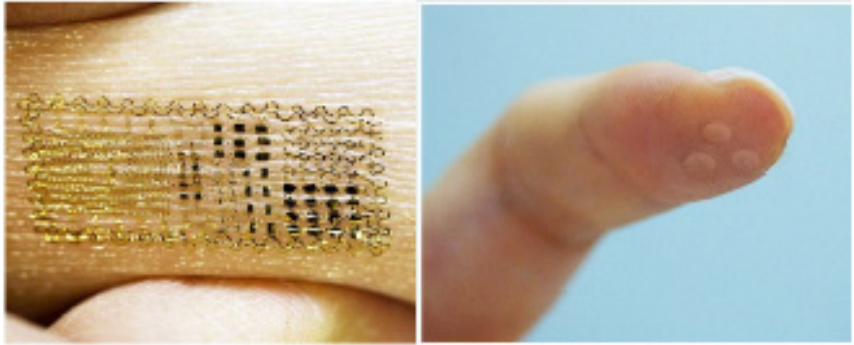
Figure 4. Smart skin sensors and finger-implanted sensors [49].